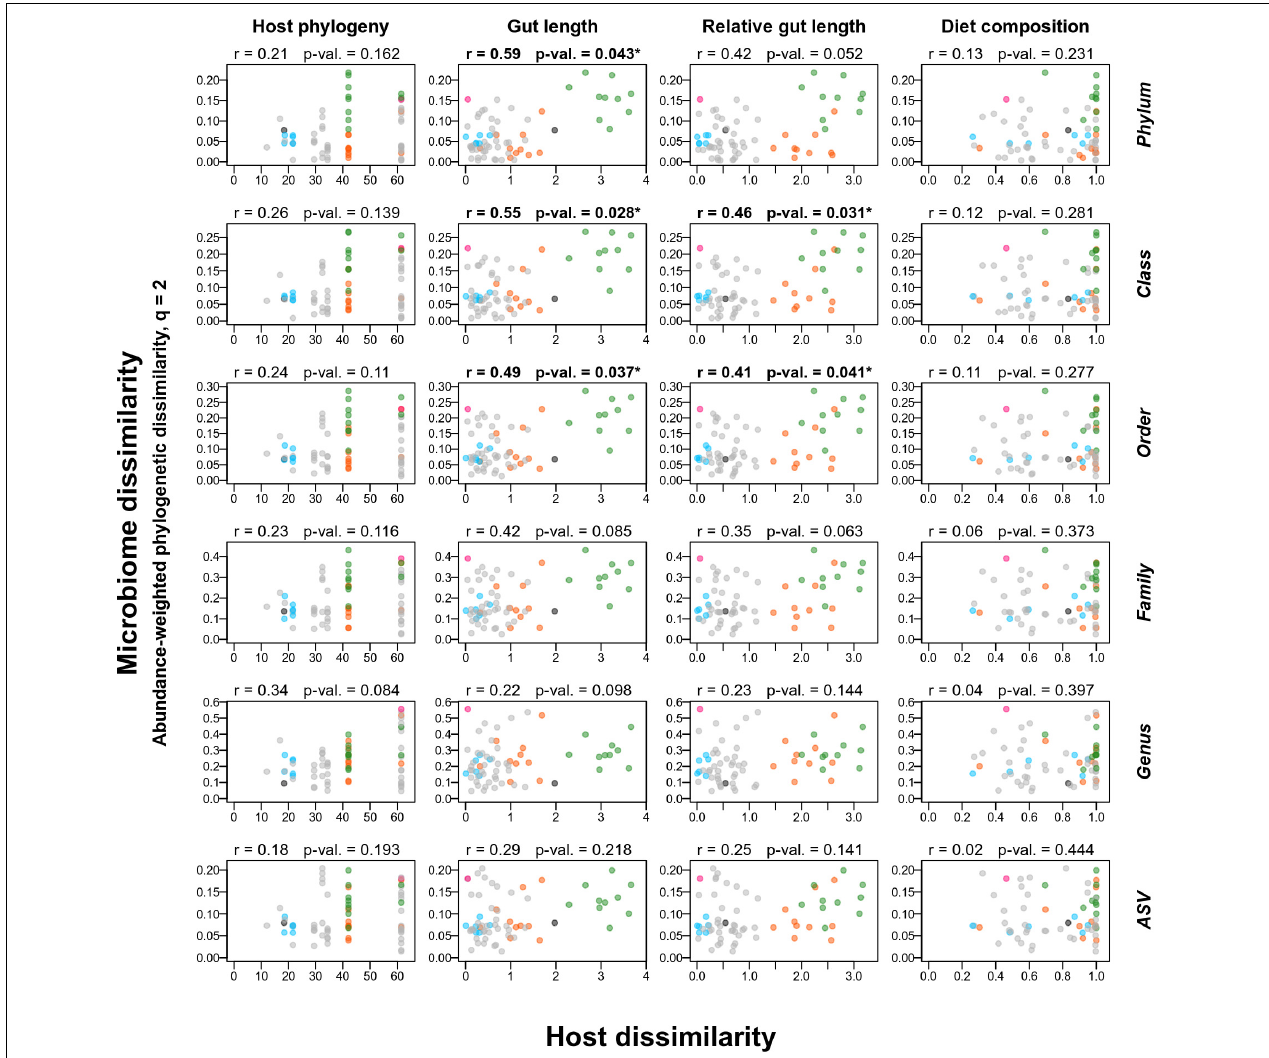
FIGURE 2 | Gut traits explain differences in the phylogenetic structure of the microbiome better than host phylogeny or diet. Relationships between dissimilarity of the gut microbiome ( Y axes) and phylogenetic, morphological, and dietary dissimilarity (columns) between host fishes ( X axis) using Mantel tests (for each subplot: r = correlation between X and Y variables and p -value = p -value of the Mantel test, bolded r and p -values correspond to significant relationships). Gut microbiome dissimilarity, here estimated using abundance-weighted Hill numbers phylogenetic index with q = 2, was computed at six different levels of taxonomic resolution (row names on the right of the figure). Each point represents a pair of fish species. Pairs within the Diplodus genus are depicted in blue, pair within the Pagellus genus is depicted in pink, pair between Sarpa salpa and Boops boops is depicted in black and other pairs that included S. salpa or B. boops are depicted in green and orange,